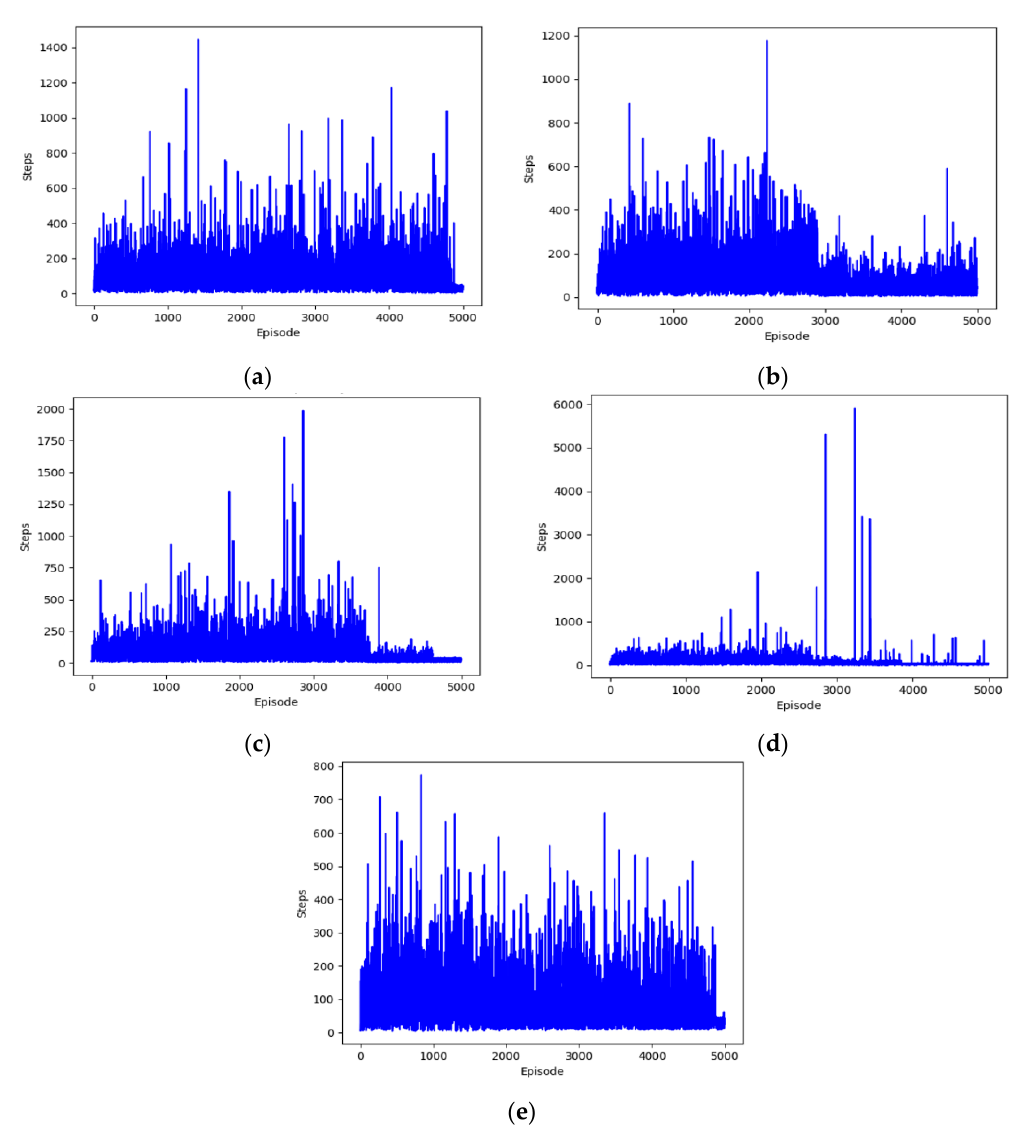
Figure 14. Path optimization learning progress status of Q-Learning with action based reward: ( a ) 1st test; ( b ) 2nd test; ( c ) 3rd test; ( d ) 4th test; ( e ) 5th test.